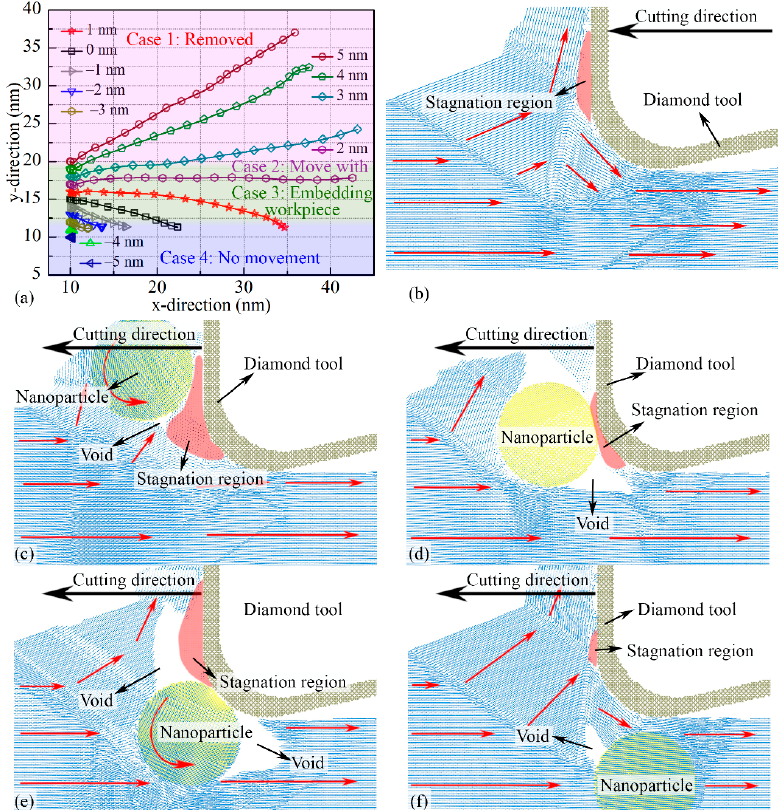
Figure 2. Position evolution of the center of the nanoparticle (NP) for different Δ D s in the x-y plane during the nano-cutting process ( a ). The atomic motion vector in the workpiece with no NPs ( b ), with NP for Δ D = 4 nm ( c ), 2 nm ( d ), 0 nm ( e ), and − 5 nm ( f ) at cutting distance of 15 nm.